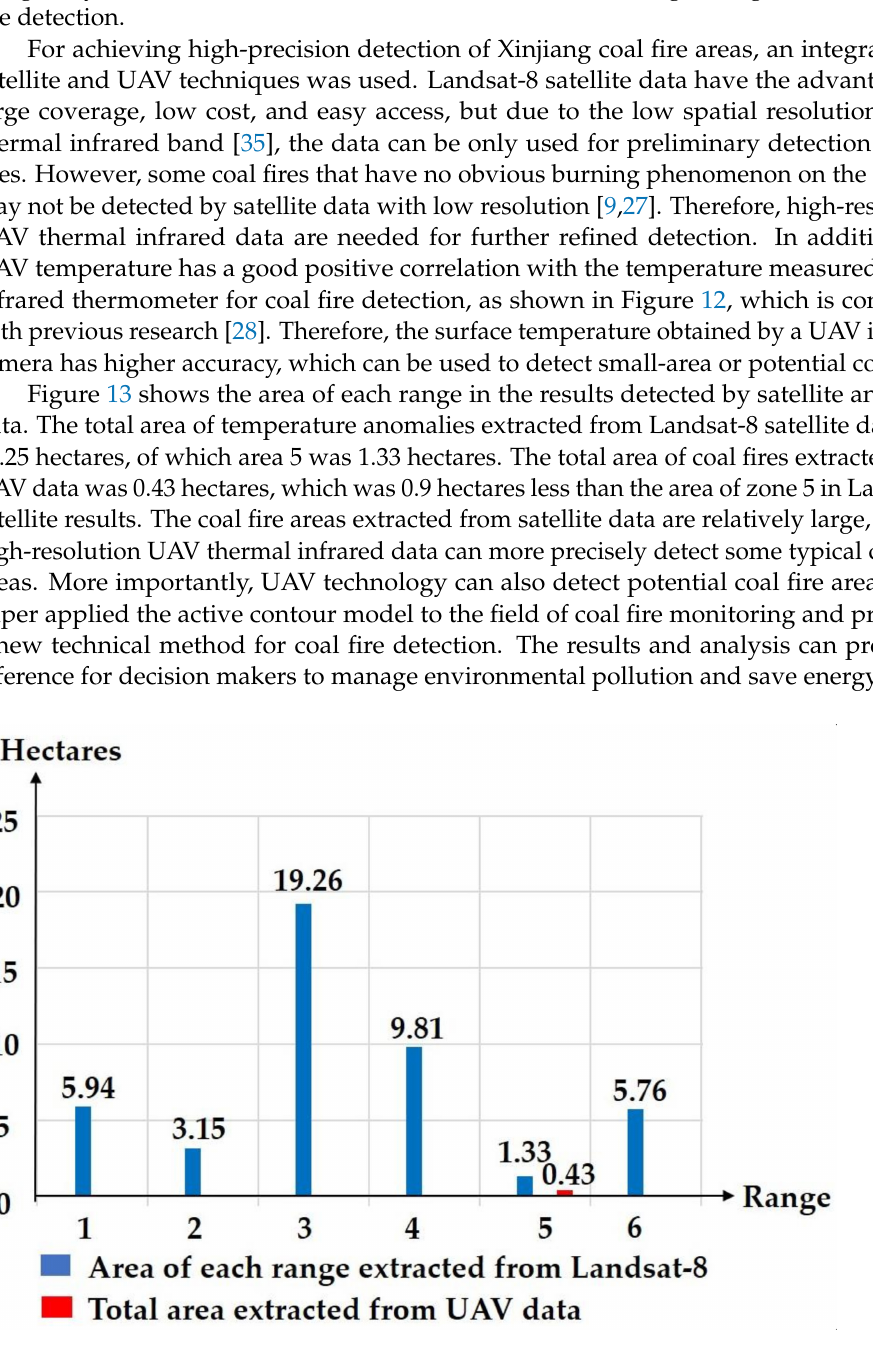
Figure 13. Area of each coal fire range extracted from satellite and UAV